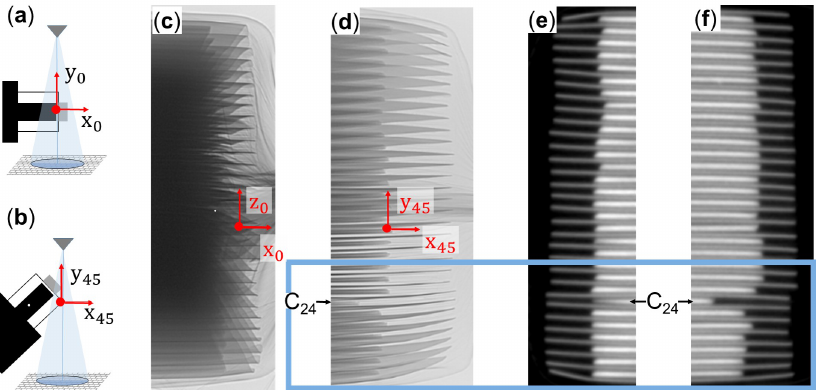
Figure 5. With the figures presented, different lateral beam directions are qualitatively evaluated: Sketch ( a ) shows the experimental setup for a lateral beam direction of the ESC corner in y 0 direction and the corresponding X-ray image is shown in ( c ). Sketch ( b ) shows the experimental setup for a diagonal lateral beam direction of the ESC corner in x 45 direction and the corresponding X-ray image is shown in ( d ). In picture ( e ) is the CT slice in x 0 z 0 -plane and in ( f ) the CT slice in y 0 z 0 -plane is